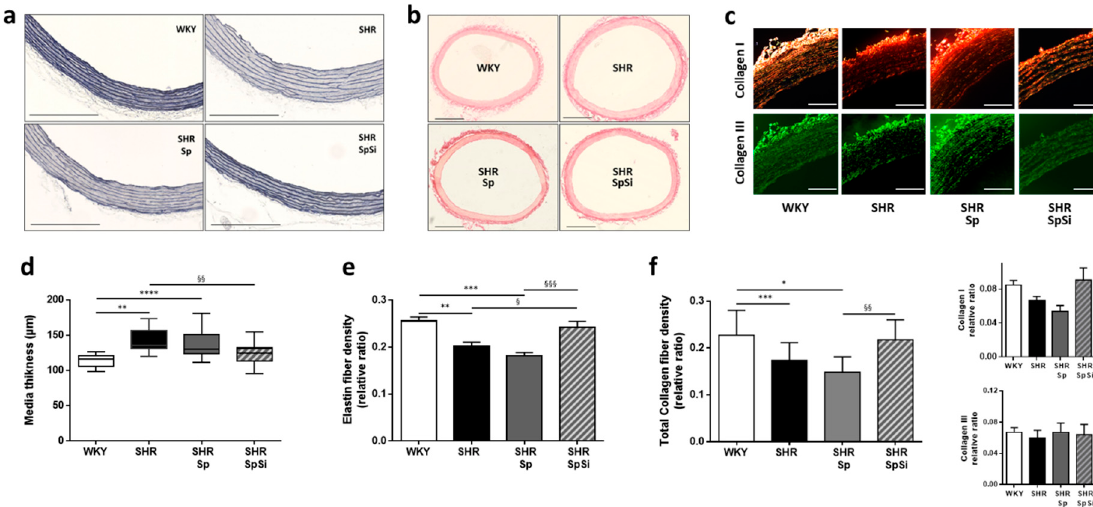
Figure 2. Effect of supplementation on morphology and ultrastructure of aorta. Images show representative histological staining of aortic samples. Bright field images illustrate ( a ) aorta stained with Verhoeff’s solution and evidencing elastin fibers structure and media thickness (scale bar 300 µm); ( b ) aorta stained with picrosirius red and showing internal and external diameters (scale bar 500 µm); ( c ) Picrosirius red stained sections illuminated under polarized light to visualize type I collagen in yellow/red and type III collagen in green (scale bar 100 µm). ( d ) Graph showing media thickness in all groups; data are presented as box and whiskers with median and SD. Bar graphs ( e ) and ( f ) summarize, respectively, elastin and collagen density quantified from 3 to 5 sections per aorta and expressed as relative ratio normalized to media layer surface. Data are presented as mean ± s.e.m (n = 15 in each group). **** p < 0.0001, *** p < 0.001, ** p < 0.01 vs. WKY; §§§ p < 0.001, §§ p < 0.01, § p < 0.05